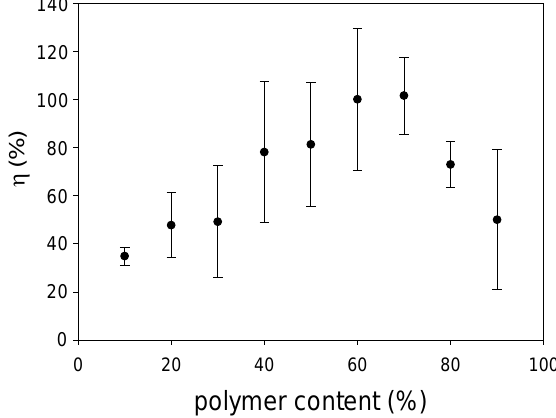
Figure 5. Relationship between the signal level,  (%), and the polymer content